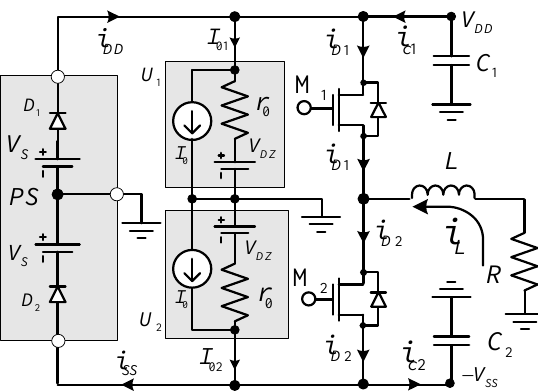
Figure 4. Principal schematic of class-D HB amplifier without control circuitry. An amplifier is powered with unidirectional power supply and augmented with pus-pumping suppression electronics. Capacitors C 1 and C 2 are large enough so that voltages on supply busses can be considered as ripple-free.